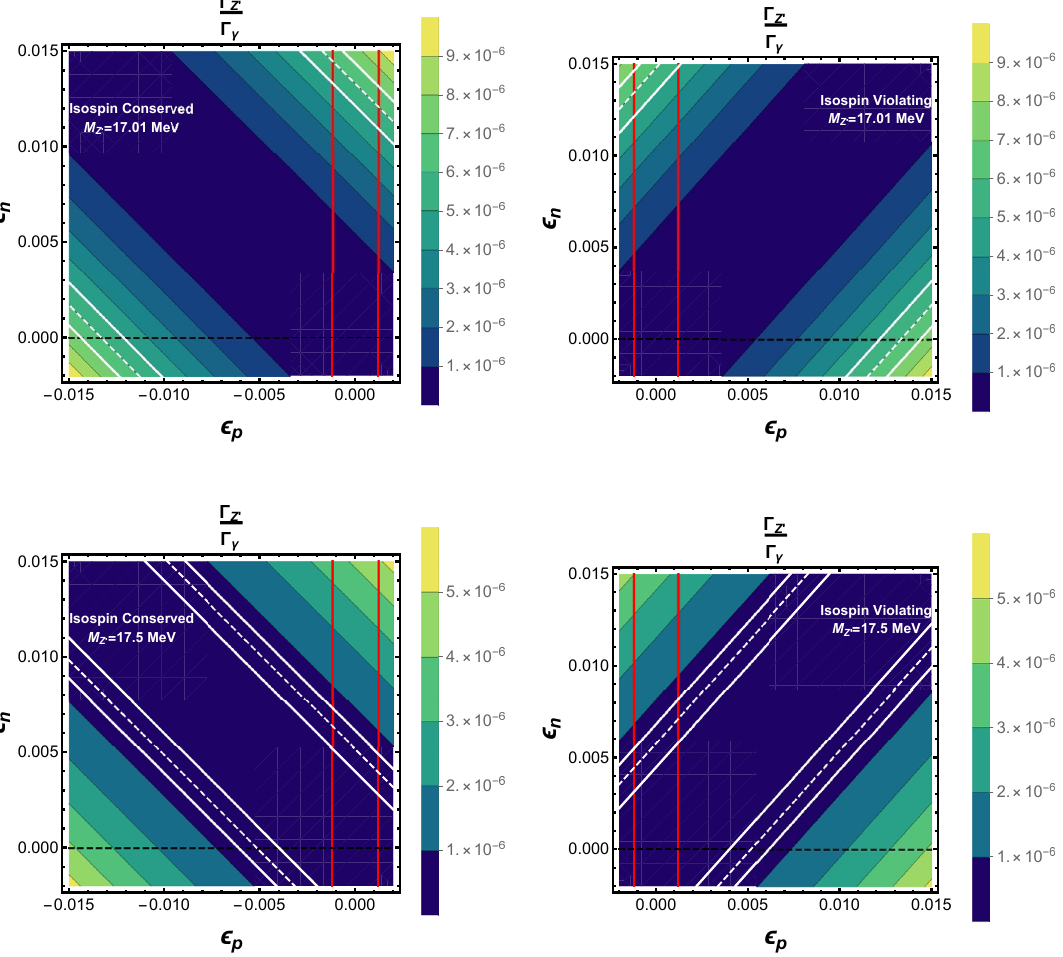
Figure 2 . On the left (right) panels, contour plots of the ratio (cid:0) Z 0 = (cid:0) (cid:13) (see eq. (4.3) for the isospin conserving (violating) limit. The white dashed and solid lines correspond to the best (cid:12)t and to the 1 (cid:27) interval for the experimental best (cid:12)t values for (cid:0) Z 0 = (cid:0) (cid:13) , under the assumption BR( Z 0 ! e + e (cid:0) ) = 1. The region between the two red vertical lines corresponds to the viable protophobic region of the parameter space, as allowed by NA48/2 constraints, while the horizontal dashed line corresponds to the pure dark photon limit. On both upper panels we have taken m Z 0 =17.01 MeV, as well as the experimental best (cid:12)t value (cid:0) Z 0 = (cid:0) (cid:13) = 6(1) (cid:2) 10 (cid:0) 6 (following the (cid:12)t values reported in [44]). The lower panels illustrate the case in which m Z 0 =17.5 MeV, for an experimental best (cid:12)t value (cid:0) Z 0 = (cid:0) (cid:13) = 0 : 5(0 : 2) (cid:2) 10 (cid:0) 6 , in agreement with the values quoted in [55] (for which we have taken a conservative estimate of the error in (cid:0) Z 0 = (cid:0) (cid:13) (cid:24) 0 : 2 (cid:2) 10 (cid:0) 6 , following the uncertainties of [44]).